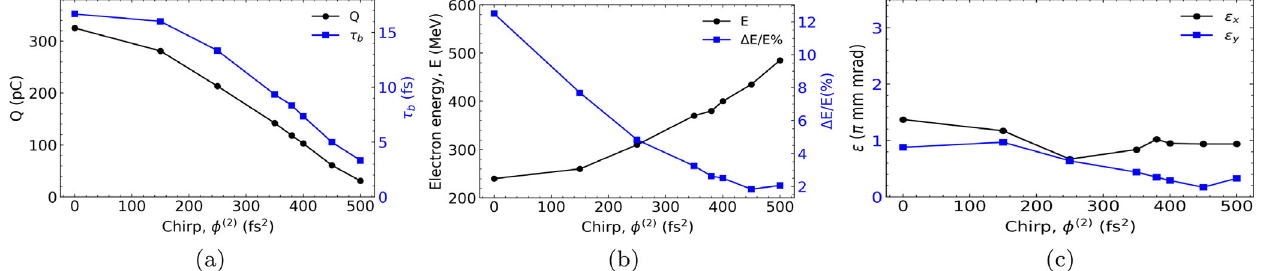
FIG. 6. Electron bunch properties with respect to the group delay dispersion ϕ ð 2 Þ of a laser pulse. (a) Charge Q (black dots) and electron bunch duration τ b (blue dots), (b) electron peak energy E (black dots) and energy spread Δ E=E (blue dots), and (c) normalized rms emittance ϵ x (black dots) in the x direction and ϵ y (blue dots) in the y direction.